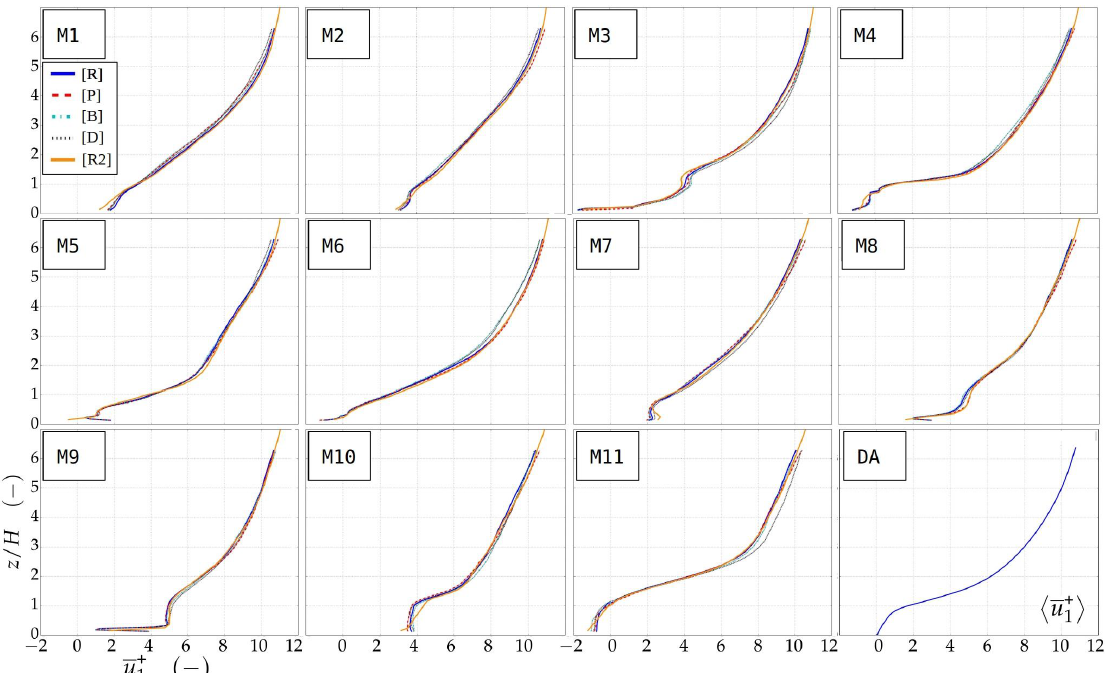
Figure 9. Normalized streamwise-rotated velocity profiles in the vertical direction obtained from each modified model simulation and all 11 virtual tower locations: A double-averaged profile is included in the bottom-right-hand corner for